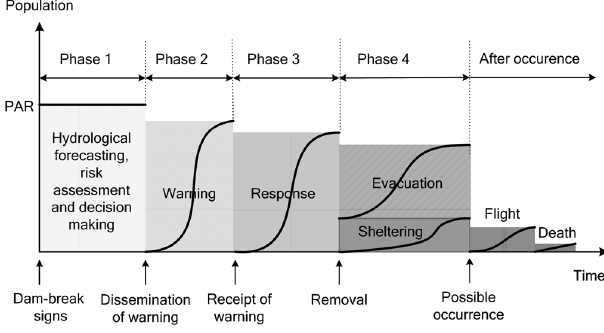
Fig. 3. Emergency management of dam breaks in time scale (modi- fied from Frieser,